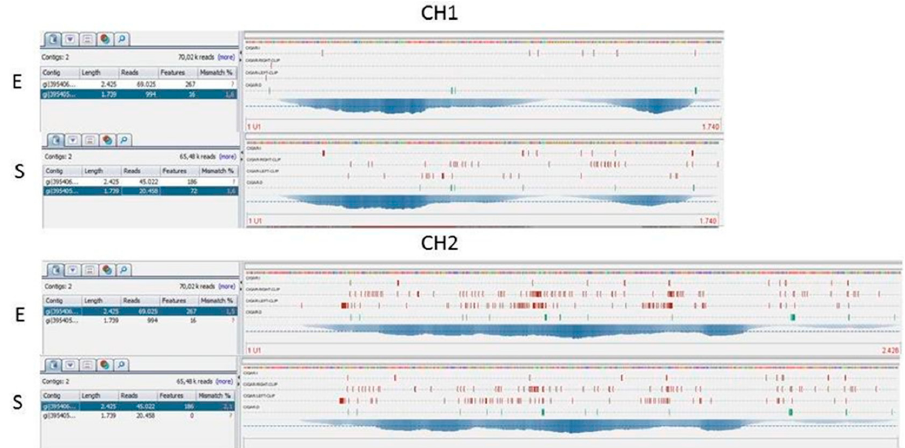
Figure 1. Graphic representation of the sequencing coverage and alignment of the reference sequence of the Ch1 and Ch2 genes. E = Short Haired cat. S = Siberian cat.